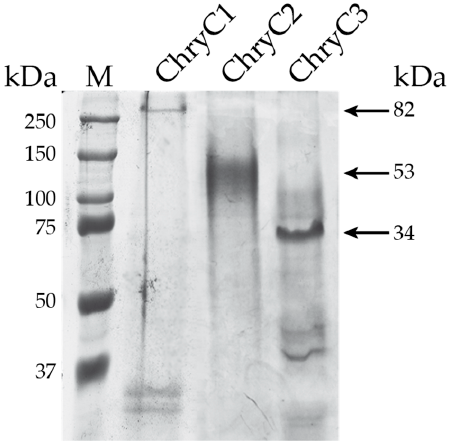
Figure 3. SDS ‐ PAGE of purified egg stalk proteins. Due to their amino acid composition, all proteins run slower than expected for their theoretical molecular weight given next to the arrows. However, such a feature is often seen for the assay for silk proteins due to an insufficient interaction with SDS [16]. First lane shows the marker (M).